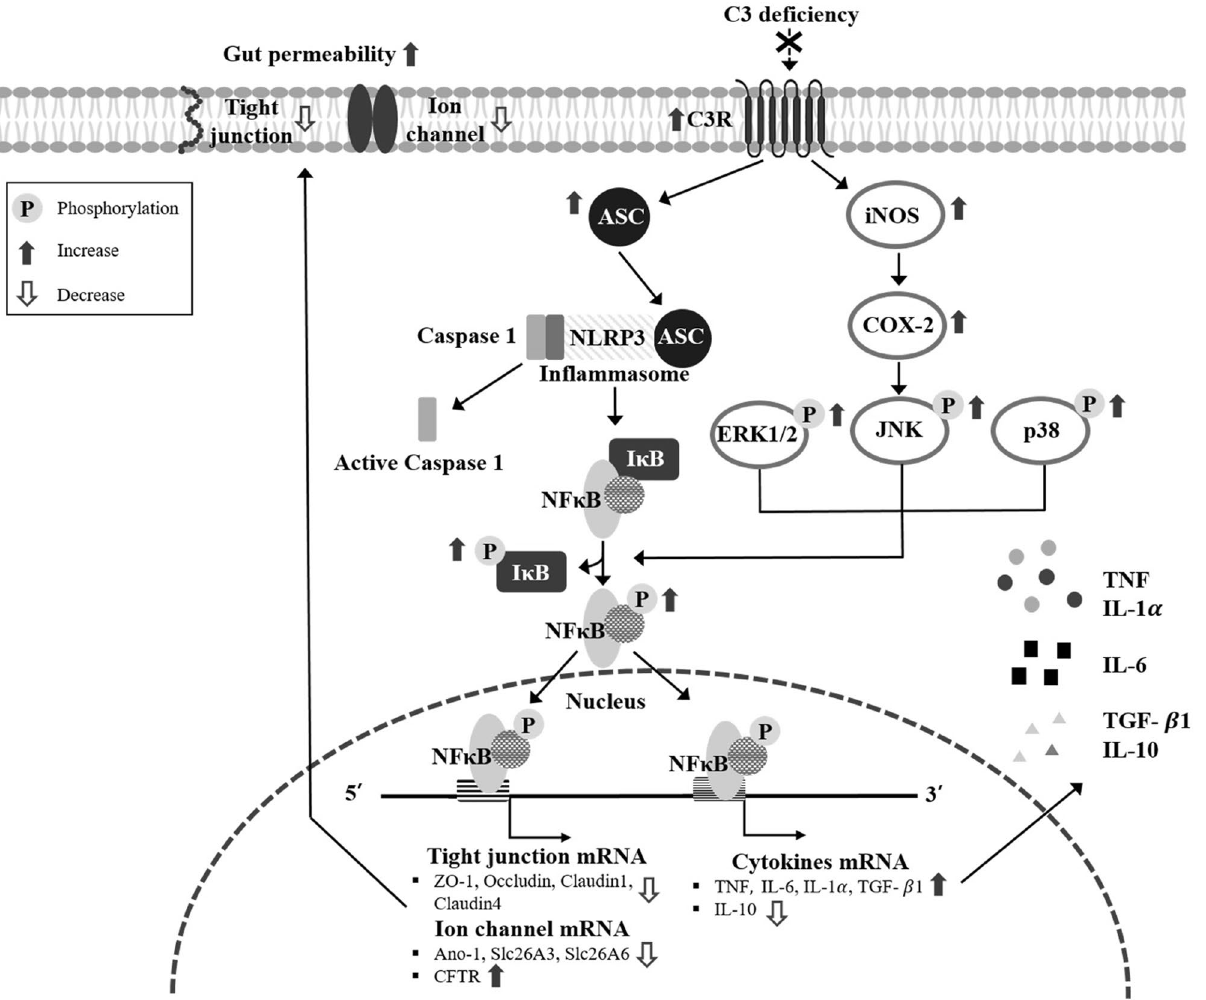
Figure 9. Suggested mechanism of inflammatory response in the C3R downstream pathway during C3 deficiency. In this scheme, the deficiency of C3 is thought to activate the iNOS-mediated COX-2 induction pathway, MAPK signaling pathway, ASC-inflammasome pathway, and NF-κB signaling pathway. Finally, activated NF-κB translocates into the nucleus, and induces the upregulation of inflammatory cytokines as well as the downregulation of tight junction channels and ion channels in the mid